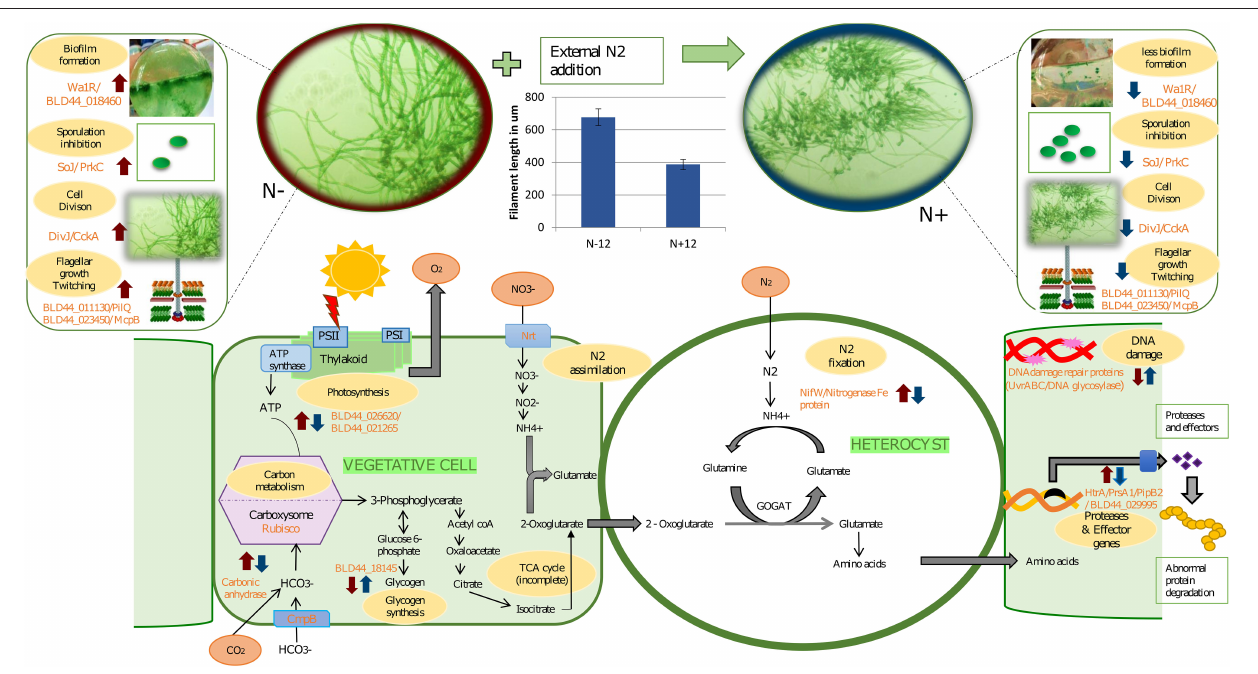
FIGURE 4 | A graphical abstract containing some of the events taking place during prolonged exposure to nitrogen under depleted nutrition. The blue arrows indicate response due to the N + condition compared to the N– condition on the 12th day of culture. Red arrows indicate mean response due to starvation on the 12th of N– grown cultures with the 0th day in N– condition. In other words, a blue arrow indicates the effect of long-term nitrogen exposure and a red arrow indicates the effect of starvation under N–. In the vegetative cells, during the N + condition, there is a reduced carbon concentrating mechanism due to the downregulation of carbonic anhydrase. Complementing this, there is a downregulation of photosystem genes and hence reduced photosynthetic activities and slow growth. Slow growth triggers the upregulation of storage products such as glycogen that is upregulated during N + condition. Among the other genes upregulated because of N– are biofilm (as seen in the image where a layer is formed at the bottom of the flask in N– condition), higher mobility in N-, and longer filaments, among others. Other genes that are affected are secretory proteins that protect the organism from predators and genes involved in DNA damage protection. We also show the increased filament length during the N– condition compared to the N +